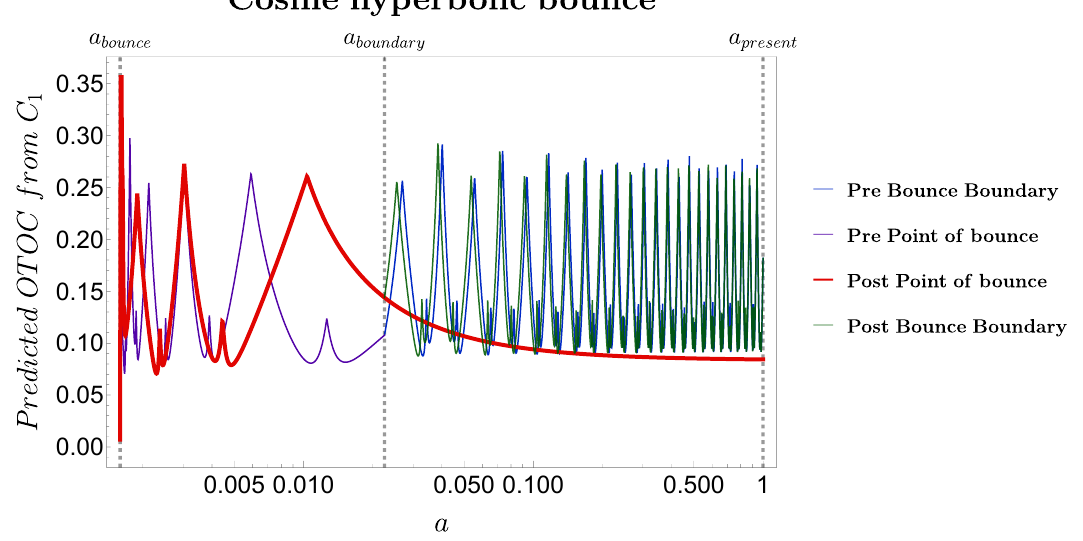
Figure 16: Predicted OTOC values from geodesically weighted Complexity at differ- ent regions against scale factor.